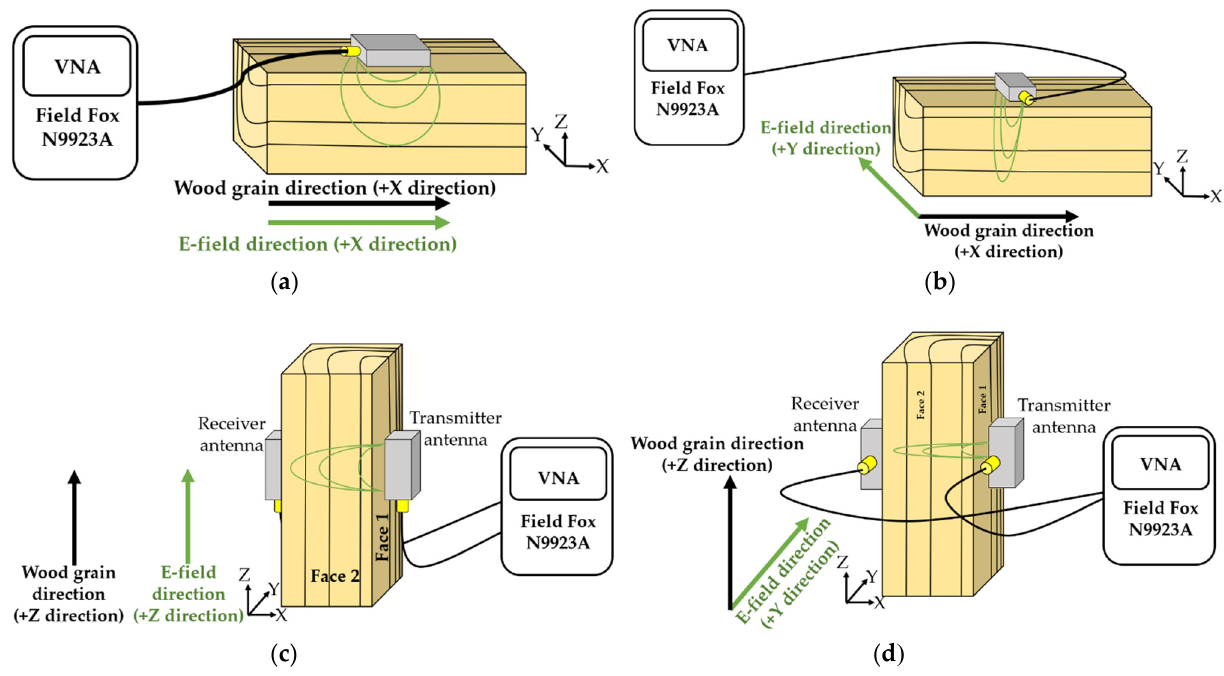
Figure 3. Reflection measurements: ( a ) E-field is parallel to the wood grain; ( b ) E-field is perpendicular to the wood grain. Transmission measurements: ( c ) E-field is parallel to the wood grain; ( d ) E-field is perpendicular to the wood grain.